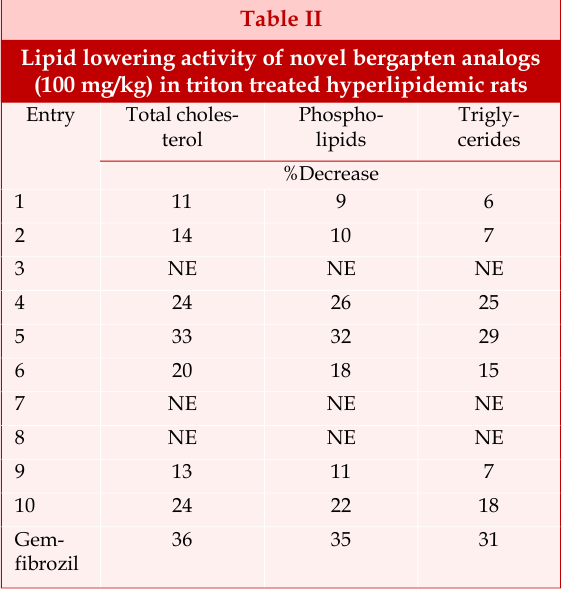
Physical and biological data of bergapten deriva- tives